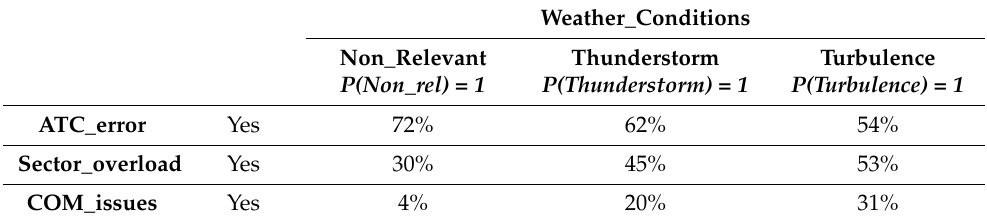
Table 10. Probability relation between nodes Weather_conditions and ATC_error, Sector_overload and